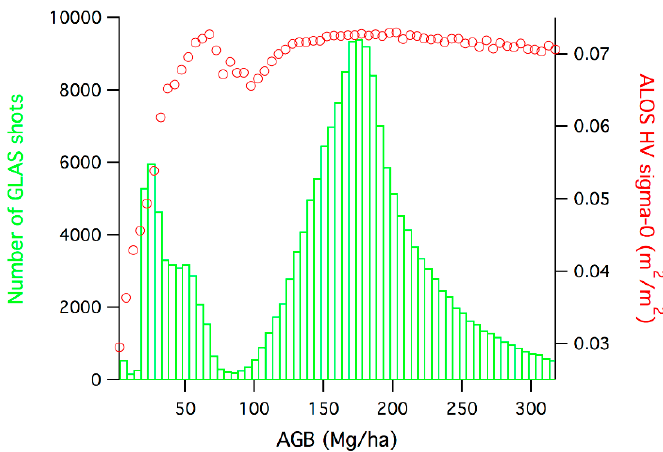
Figure 8. Statistical analysis for freshwater flooded forest category. Red markers are the bin-averaged ALOS HV sigma-0 values. Green histogram shows the total number of GLAS shots within each